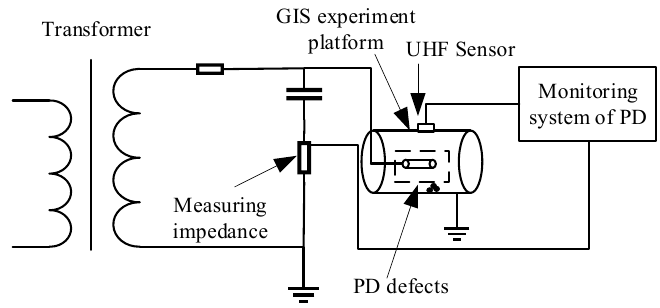
Figure 2. PD detection platform of GIS.